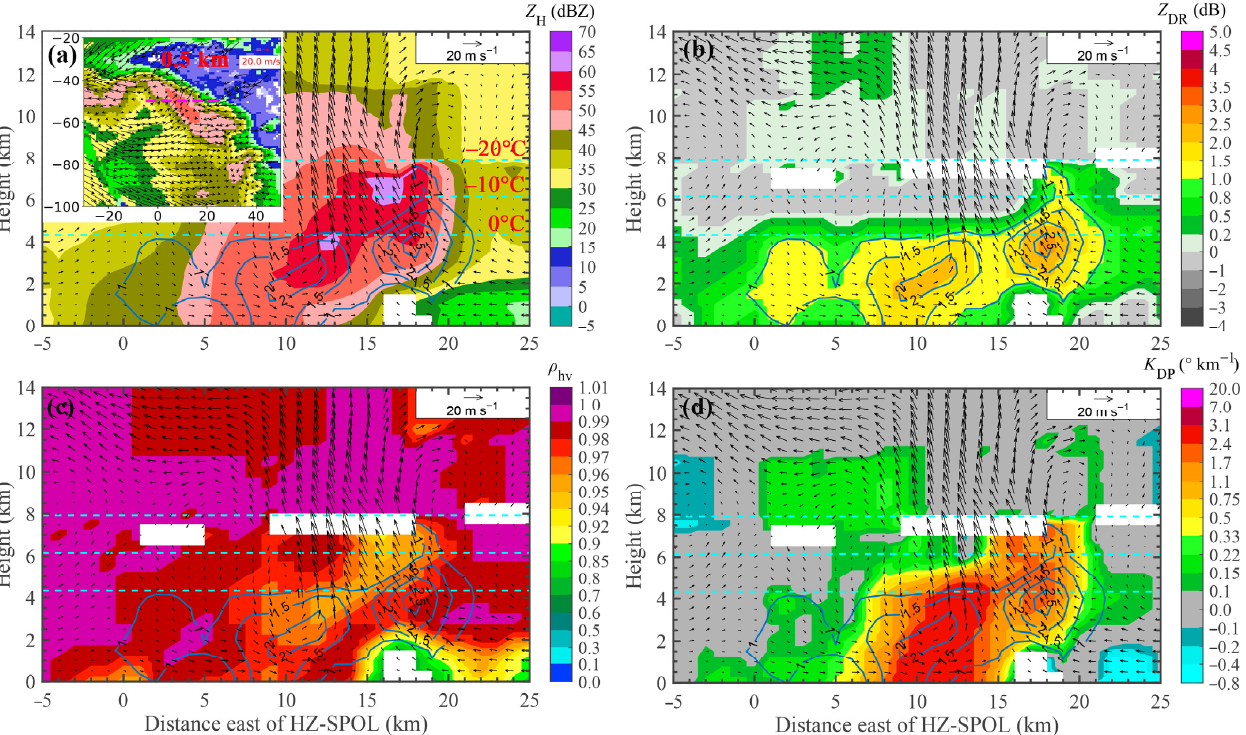
Figure 9. As in Figure 8, ( a ) Z H , ( b ) Z DR , ( c ) ρ hv , and ( d ) K DP , but for the retrieved wind fields from dual-Doppler radar (HZ-SPOL and NB-SPOL) along the cross section (the dashed red line) as in the inset of ( a ) at 2348 BT. The inset in ( a ) represents the storm-relative wind field at a height of 0.5 km MSL in the magenta dashed box in Figure 1b,c.